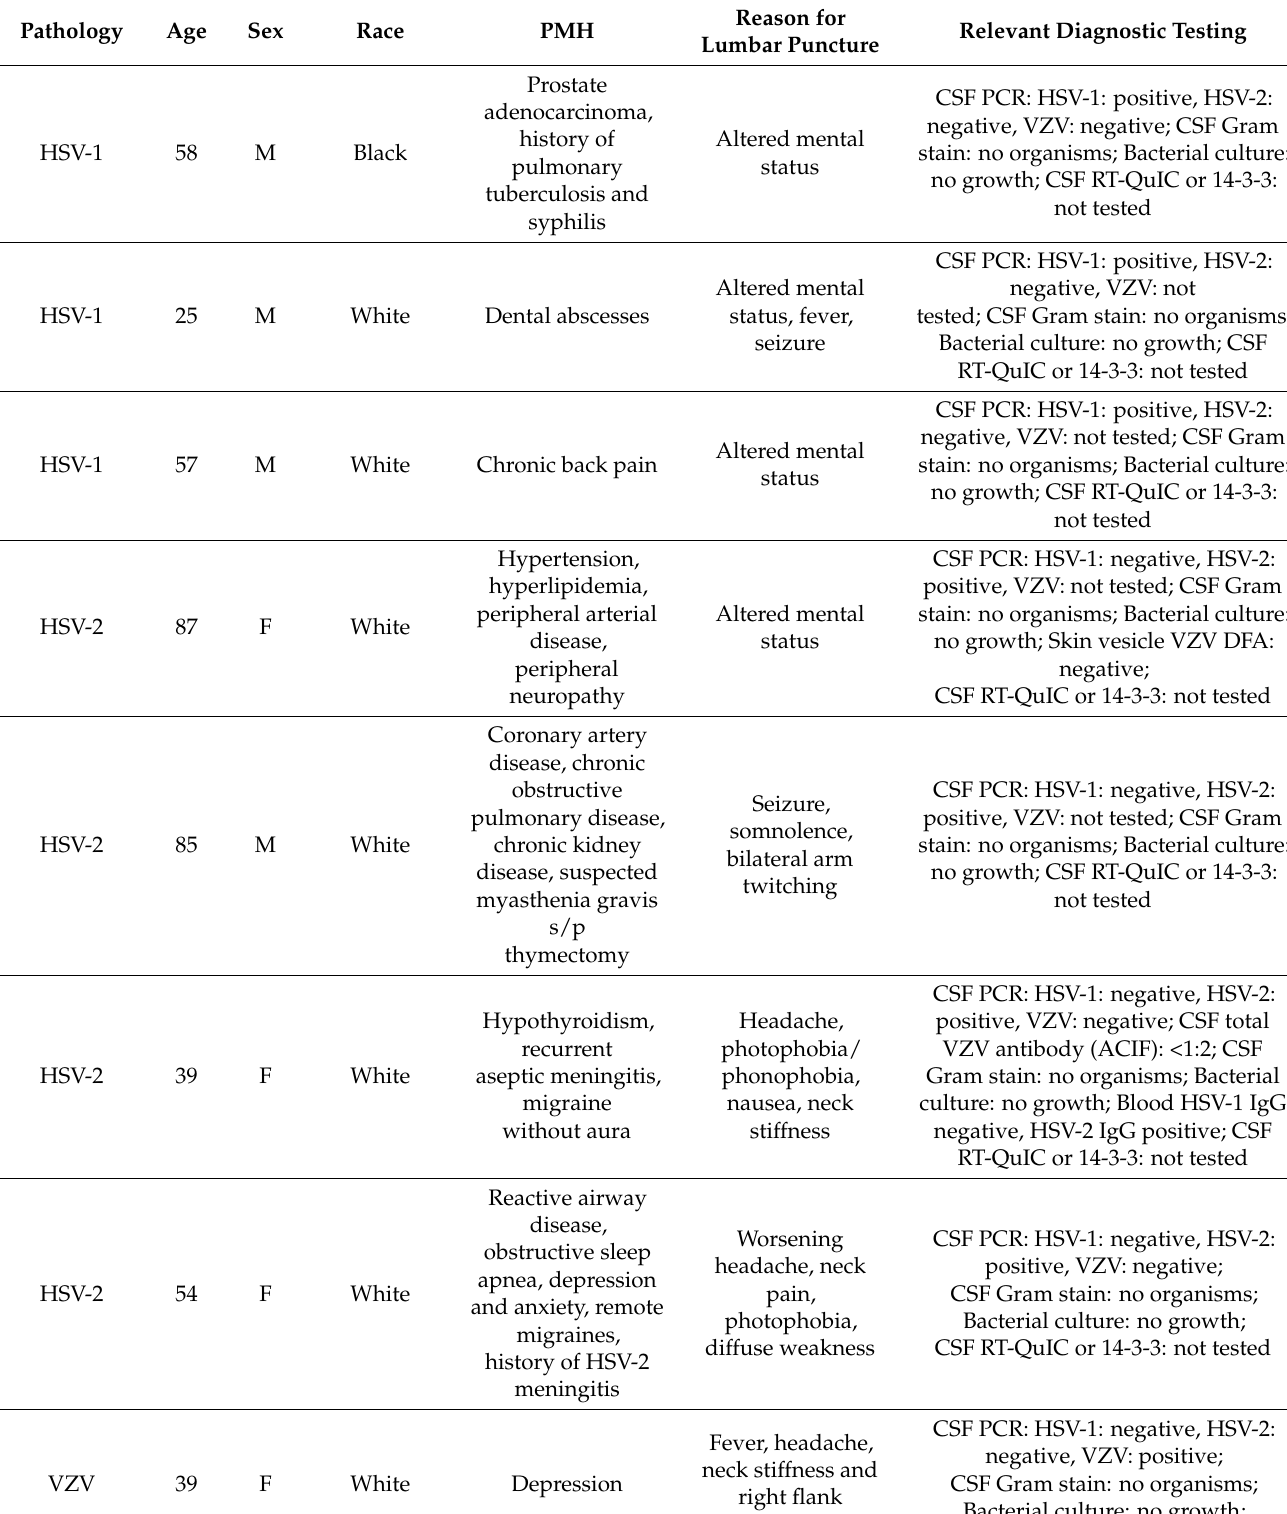
Table 1. Characteristics of